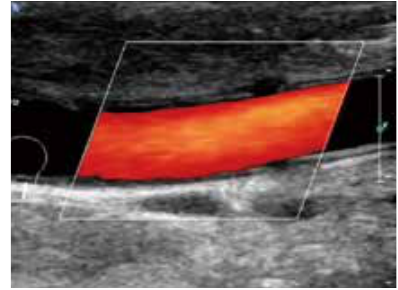
Figure 5 No significant change in the follow-up of the right common carotid artery dissecting aneurysm after two months of conservative treatment.